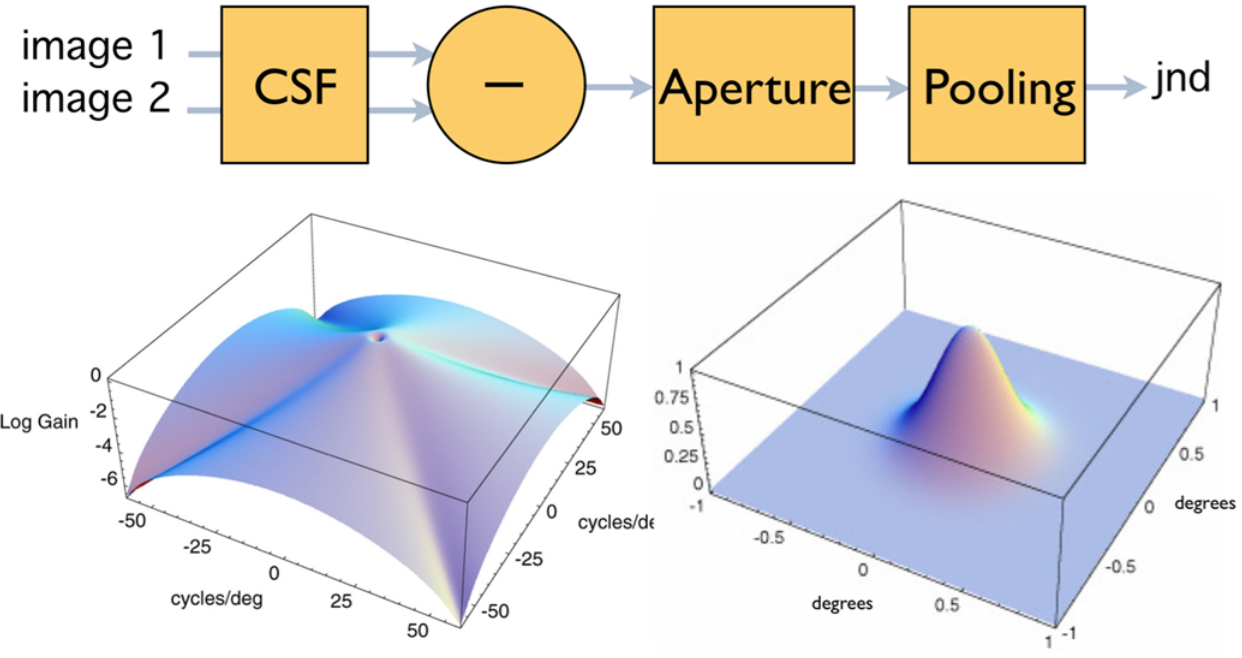
Figure 1. Overview of the Spatial Standard Observer. The upper diagram shows the sequence of operations. The lower left shows the CSF in the spatial frequency domain, and the lower right image shows the Gaussian spatial aperture in the space